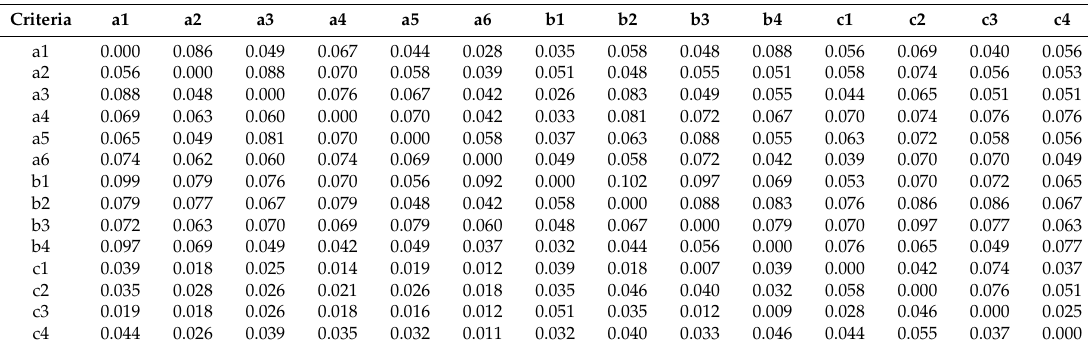
Table 8. Normalized initial direct-relationship